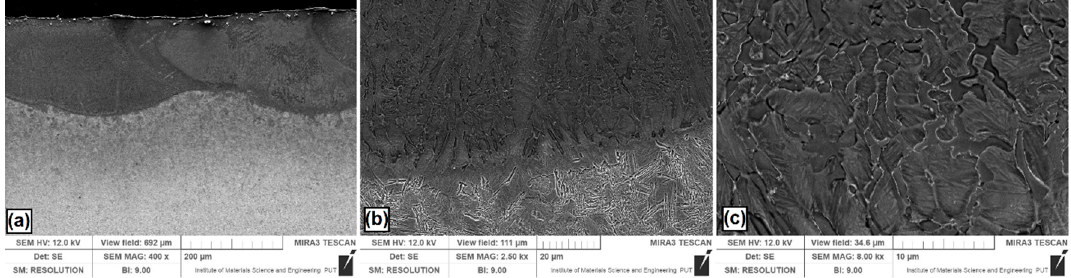
Figure 3. Microstructure of Si coatings after laser alloying: ( a ) laser tracks; ( b ) boundary between the melted zone (MZ) and the heat affected zone (HAZ); ( c ) magnification of selected area in the MZ.